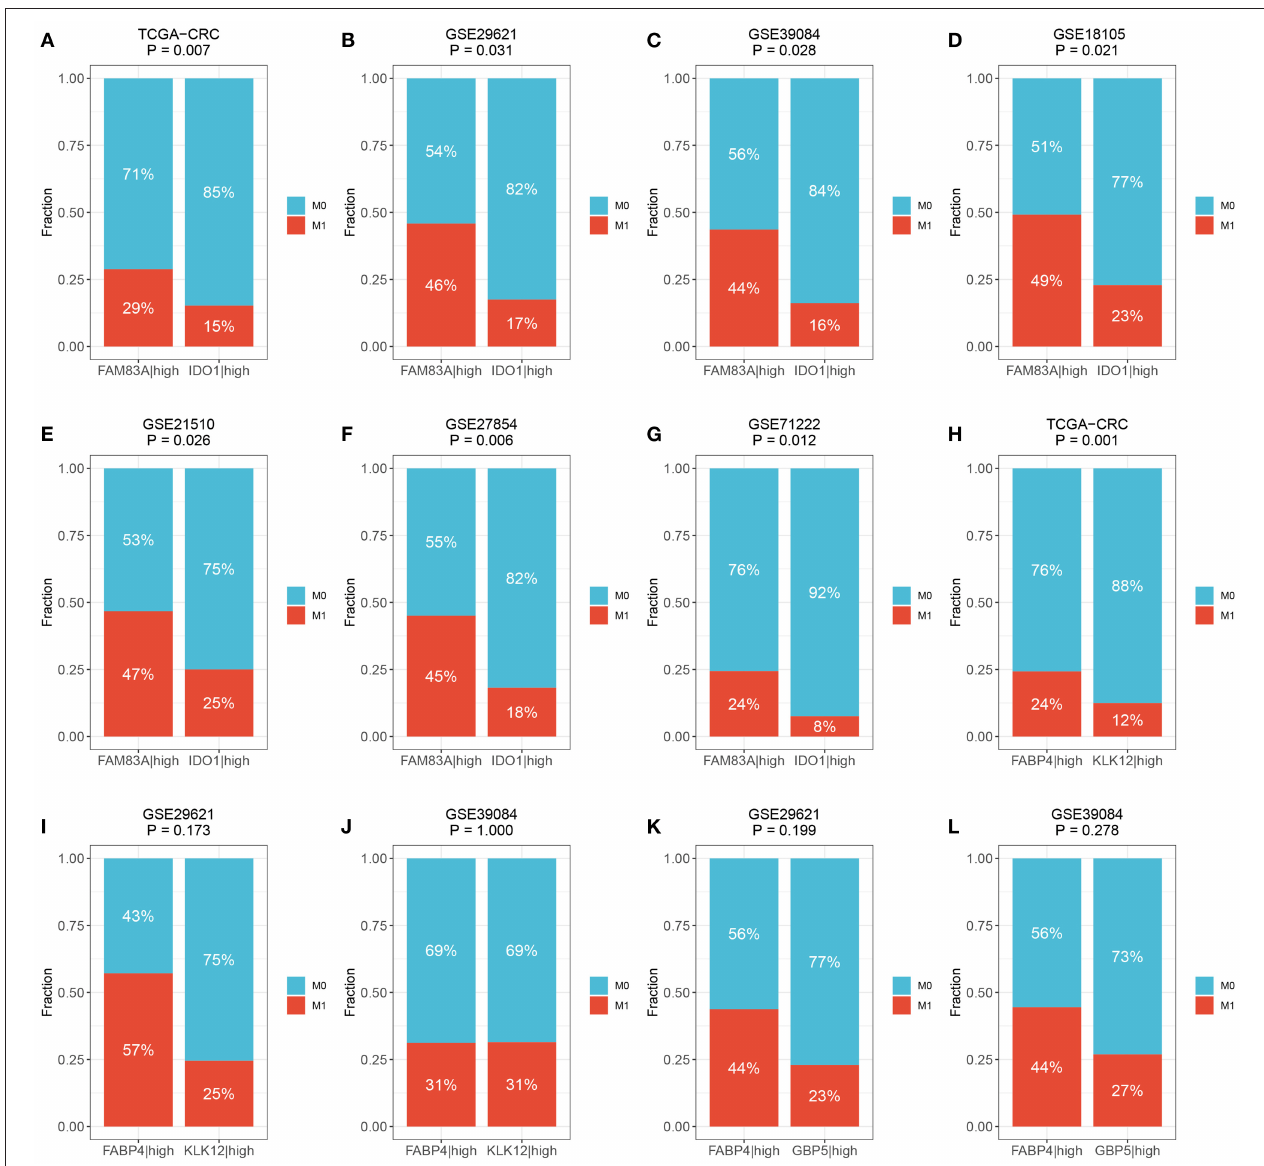
FIGURE 8 | The predictive ability of three prognostic relevant gene pairs for distant metastasis. (A–G) The relative proportion of patients with distant metastasis between FAM83A |high and IDO1 |high groups in the TCGA-CRC (A) , GSE29621 (B) , GSE39084 (C) , GSE18105 (D) , GSE27854 (F) , and GSE71222 (G) cohorts. (H–J) The relative proportion of patients with distant metastasis between FABP4 |high and KLK12|high groups in the TCGA-CRC (H) , GSE29621 (I) , and GSE39084 (J) cohorts. (K,L) The relative proportion of patients with distant metastasis between FABP4|high and GBP5 |high groups in GSE29621 (K) and GSE39084 (L) cohorts. M0, no metastasis; M1,